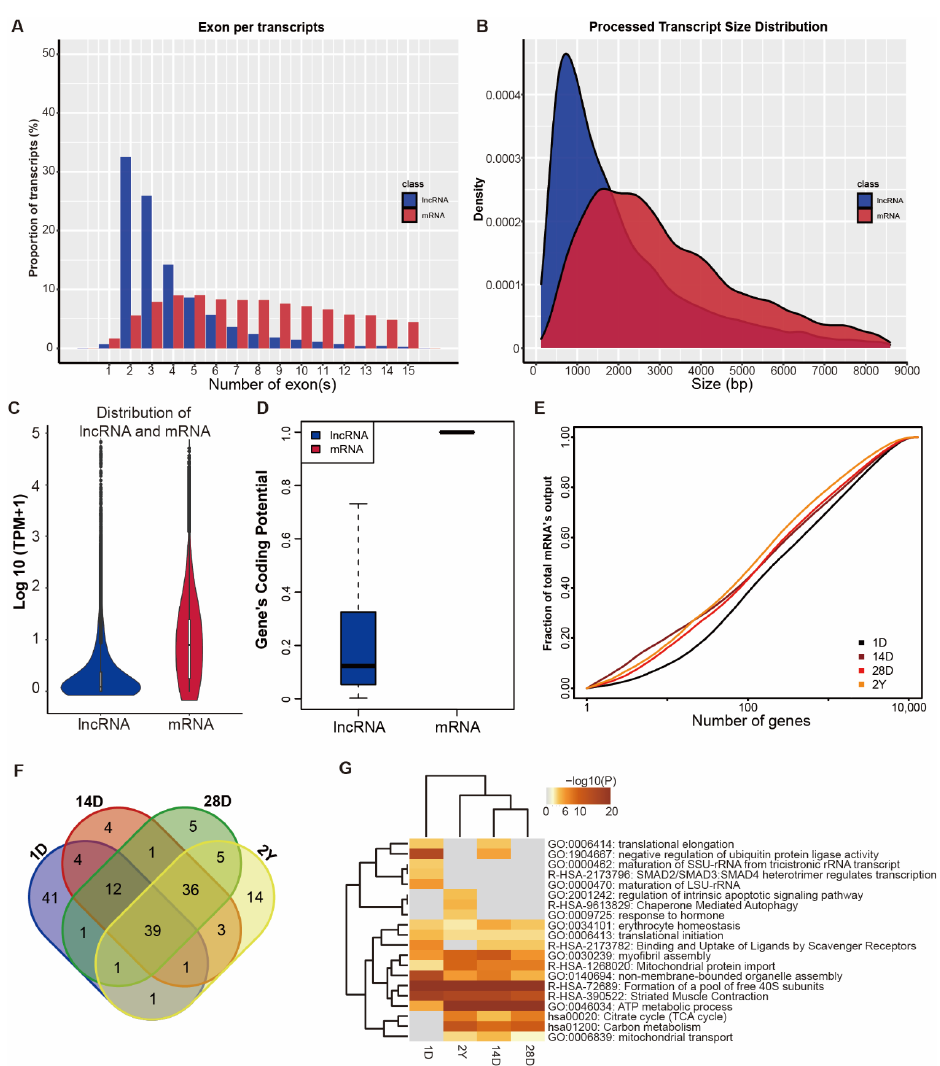
Figure 1. Genomic and transcriptional characterization of lncRNAs and mRNAs. ( A , B ) Exon num- ber ( A ) and transcript size distribution ( B ) of lncRNAs and mRNAs. ( C ) The expression level and ( D ) coding potential of lncRNAs and mRNAs. ( E ) Cumulative distribution and ( F ) Venn diagrams of the top 100 highly expressed mRNAs in four developmental phases. ( G ) Function enrichment of the top 100 highly expressed mRNAs across four developmental stages. The stages of 1 day, 14 days, 28 days, and 2 years are represented by 1D, 14D, 28D, and 2Y. We used hierarchical clustering and Pearson ’s correlation to analyze the expression of mRNAs and lncRNAs in each sample (Figures 2A,B and S1). We found that mRNA and lncRNA expression data in pigeon breast muscles were mainly grouped into four clusters